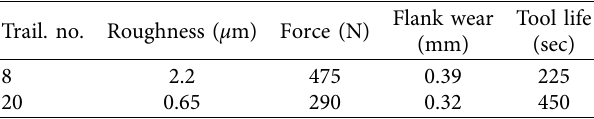
Figure 8: (a) At cutting speed � 130 (m/min), feed � 0.045 (mm/rev) and depth of cut � 0.30(mm), (b) at cutting speed � 70(m/min), feed � 0.139 (mm/rev) and depth of cut � 0.30(mm). Table 8: Machining responses at Trail 8 and